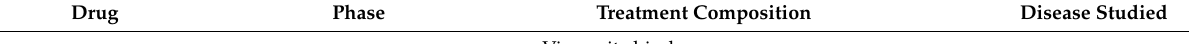
Table 2. Microtubule-targeting agents in clinical